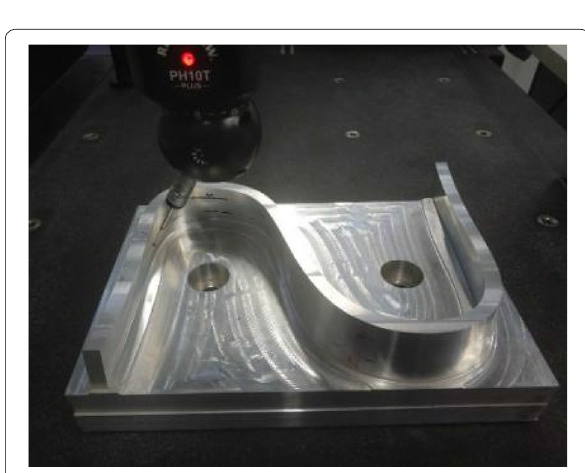
Figure 4 CMM experiment for S-shaped test specimen